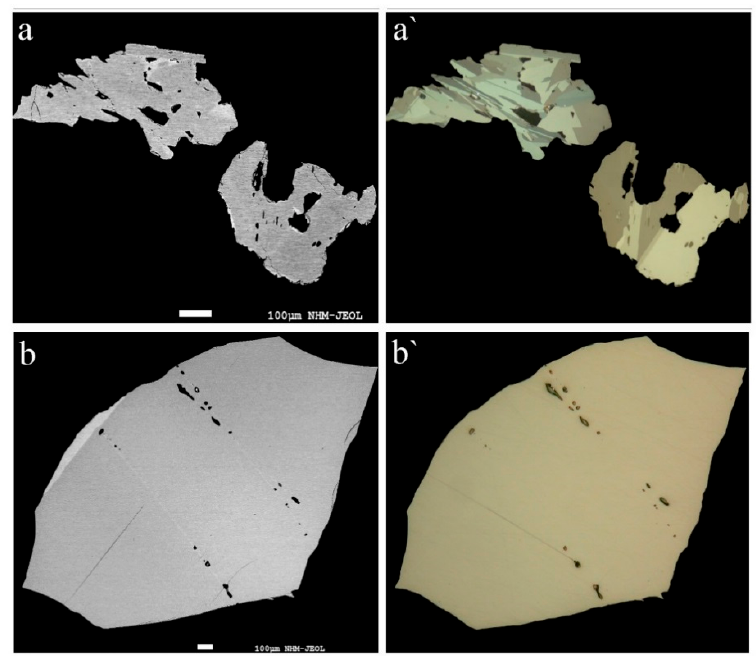
Figure 3. Representative backscattered electron images and corresponding reflected-light photographs (crossed polars) of high-Sb rathite (white) intergrown with low-Sb bulk areas: ( a ) containing rath14 and rath15 from Lengenbach; ( b ) containg rath12 and rath13 from Reckibach.